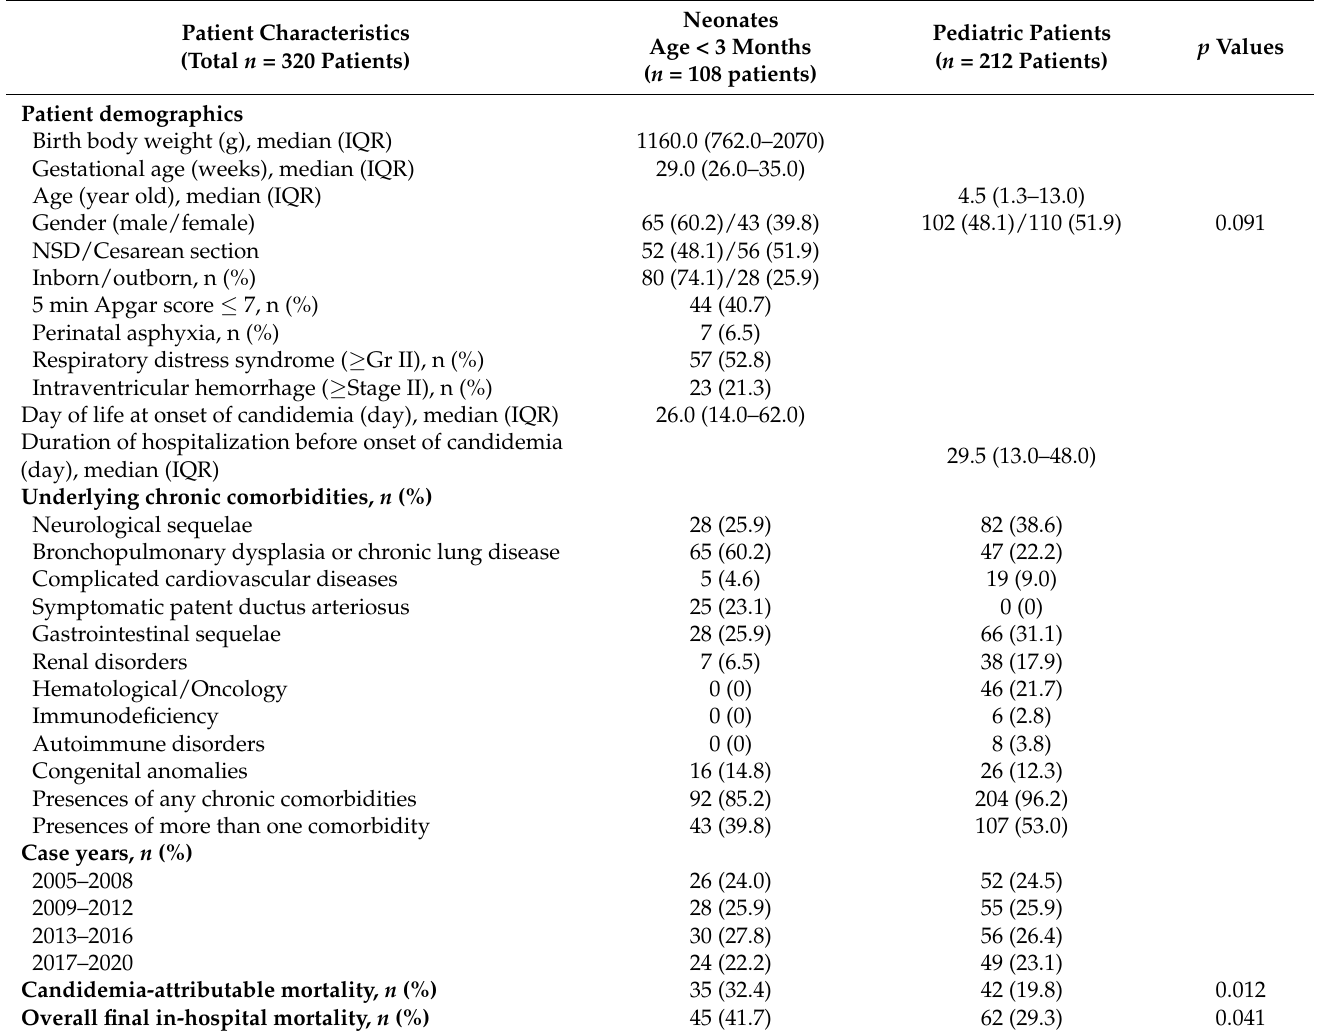
Table 1. Patient demographics of 320 children with Candida bloodstream infections in CGMH,